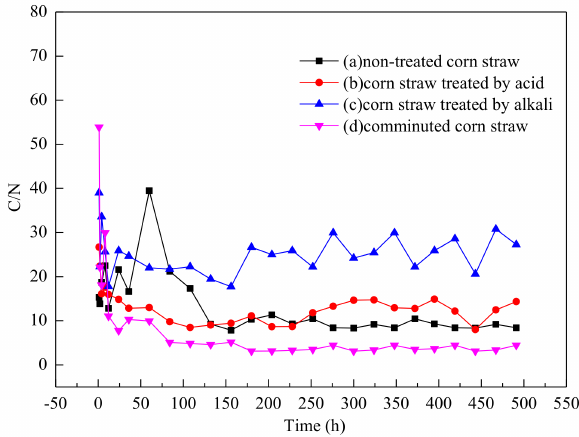
Figure 3. C/N variation trends of corn straw pretreated with different